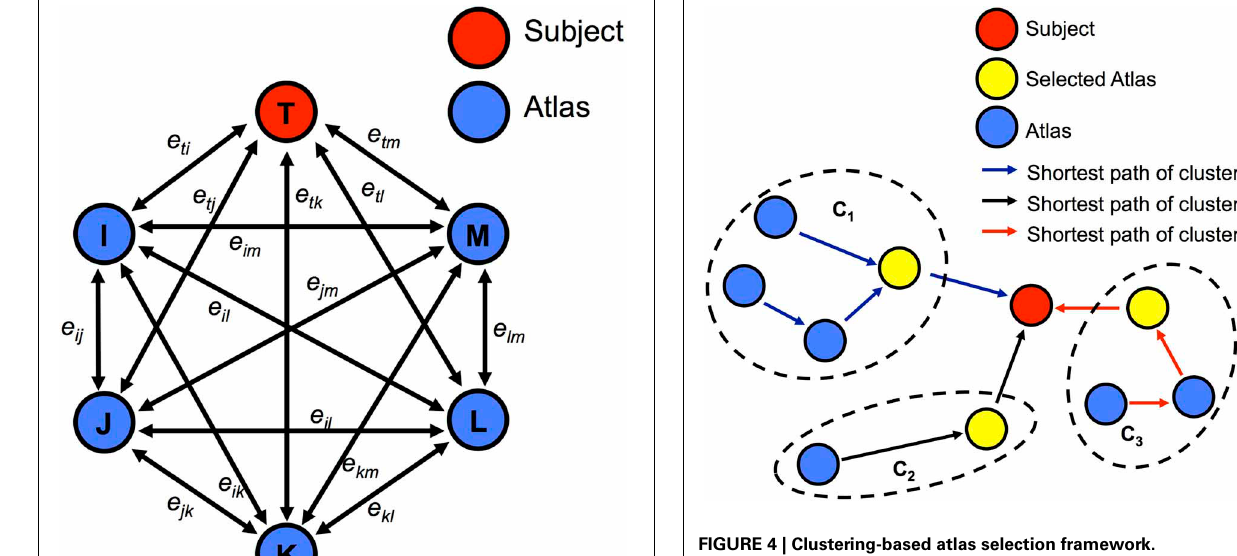
FIGURE 4 | Clustering-based atlas selection